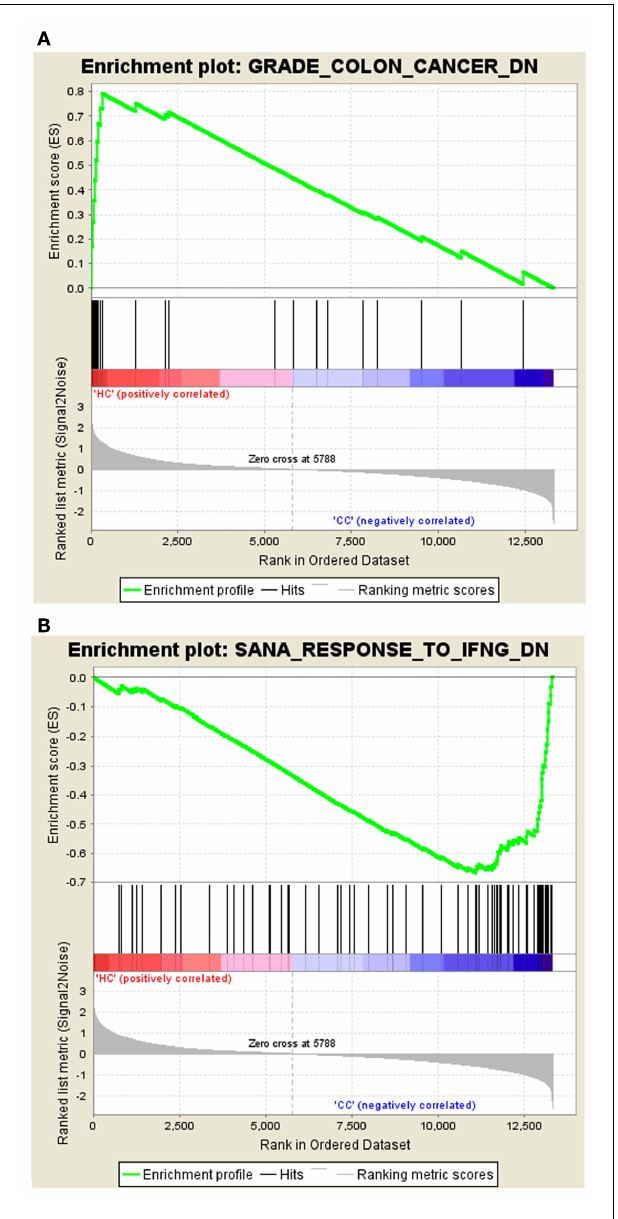
FIGURE 1 | Profile of the running ES score and positions of MSigDB gene set members on the rank ordered list. (A) Enrichment plot for